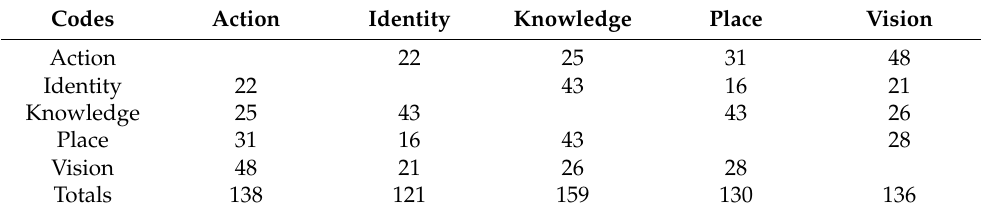
Table 5. Co-occurrence of CEA